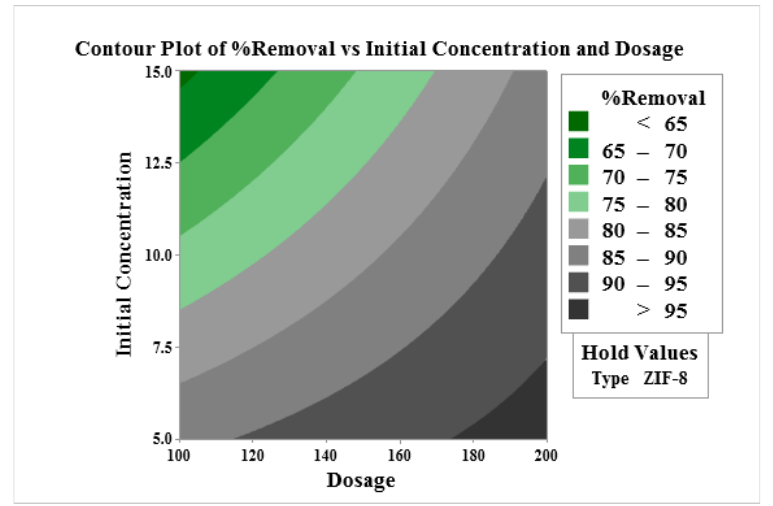
Figure 13. Surface graph of dye removal showing interaction of ( A ) dosage and initial concentration, ( B ) type and initial concentration, and ( C ) type and dosage.